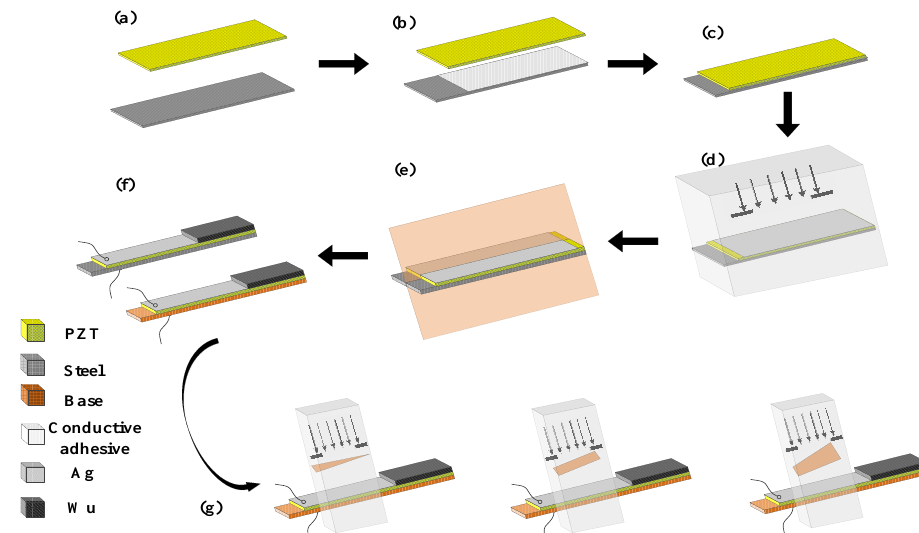
Figure 3. Manufacturing procedure for the PEH: ( a ) Polishing the piezoelectric ceramic and stainless steel. ( b ) Screen printing bonding layer. ( c ) Thermal compression bonding of bulk PZT and metal layer. ( d ) Screen printing of the upper electrode layer. ( e ) Laser cutting. ( f ) Bonding of leads and proof masses. ( g ) Formation of hollowed-out devices.